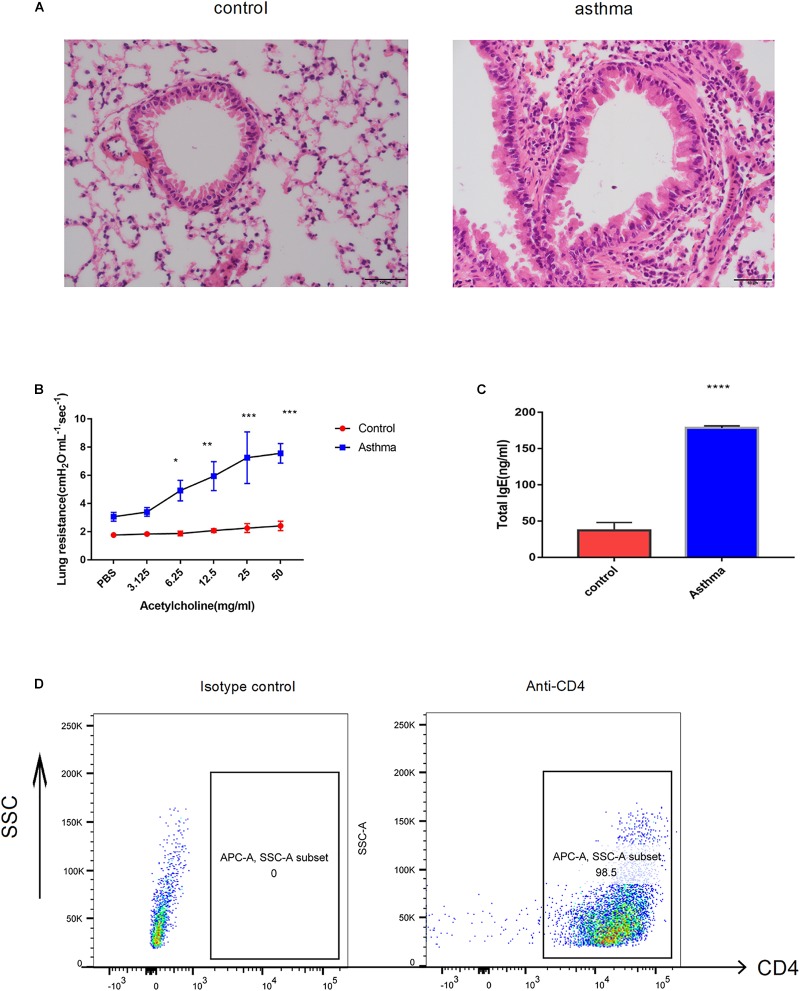
Ovalbumin (OVA)-induced acute model of asthma. (A) Pulmonary inflammatory response was increased in the mice challenged with OVA, bar = 20 μm. (B) The airway hyperresponse was elevated in the mice from the asthma group, ∗p < 0.05 (C). Sera IgE was significantly increased in the mice from the asthma group, ∗p < 0.05. (D) CD4+ T cells magnificently sorted from the spleen were validated by flow cytometry. Representative results of two independent experiments with five mice in each group, ∗∗p < 0.01, ∗∗∗p < 0.01, ∗∗∗∗p < 0.0001.